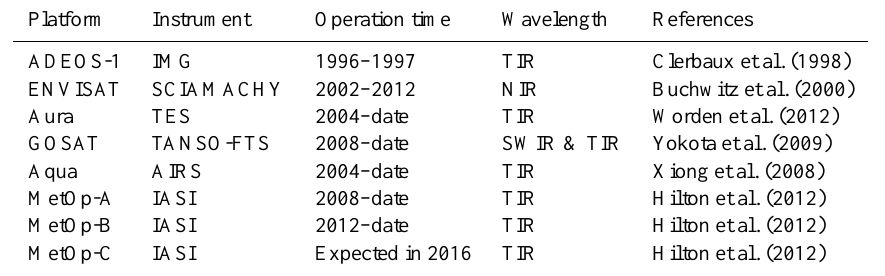
Table 1. Nadir-viewing instruments having the capabilities to measure CH 4 in the troposphere. Please, refer to the text for the acronyms.